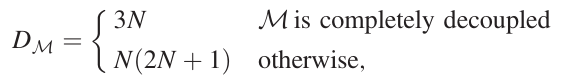
Symbol Description σ Parameters to be varied